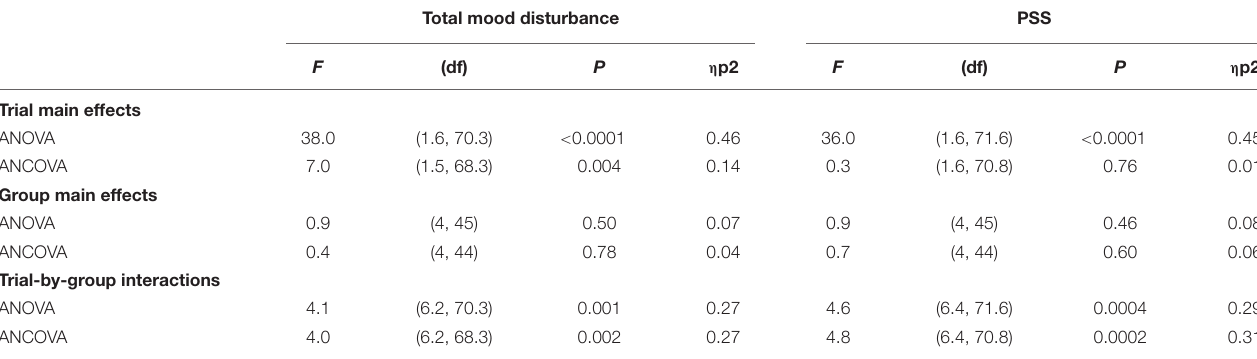
TABLE 2 | Effect differences in post intervention TMD and PSS outcomes when baseline stress has (ANCOVA) and has not (ANOVA) been controlled